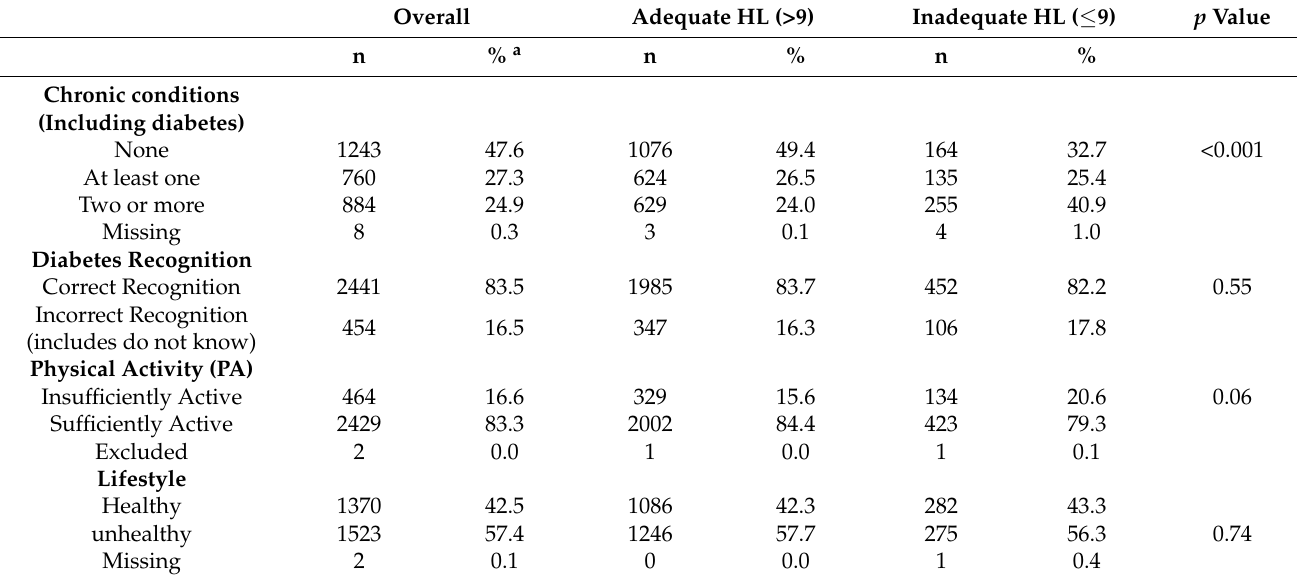
Table 3. Prevalence of chronic conditions, diabetes recognition, healthy lifestyle and PA.